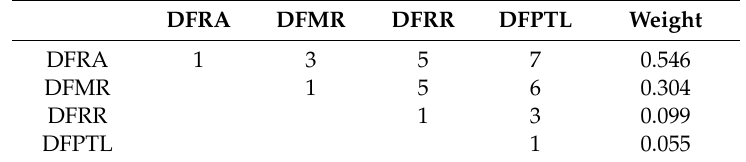
Figure 8. Exposure-related factors: ( a ) Distance from main roads, ( b ) distance from rural roads, ( c )